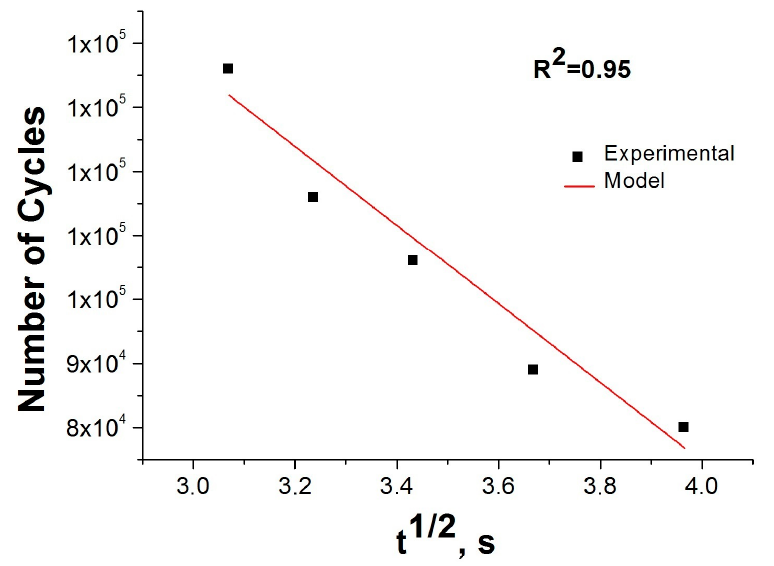
Figure 9. Number of cycles vs. laser interaction time (Scan speed = 20 mm/s).